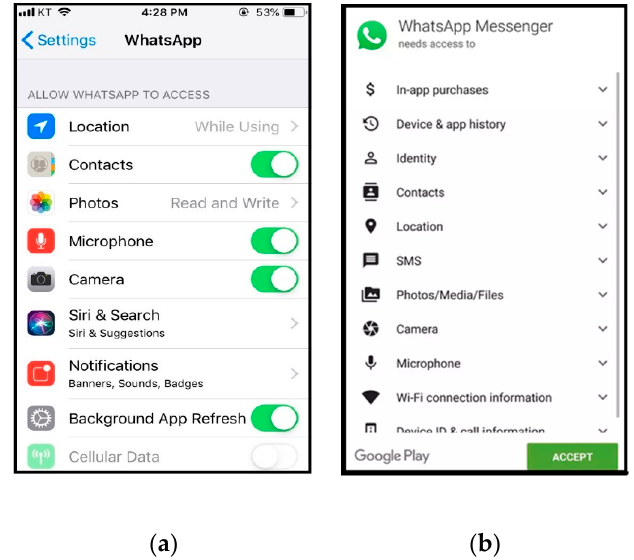
Figure 2. Screenshot of an app permission gathering system: ( a ) Apple (iOS) and ( b ) Google (Android). Table 2. Android permission (dangerous Android permissions), reproduced with permission from [59], Google Developers, 2018.